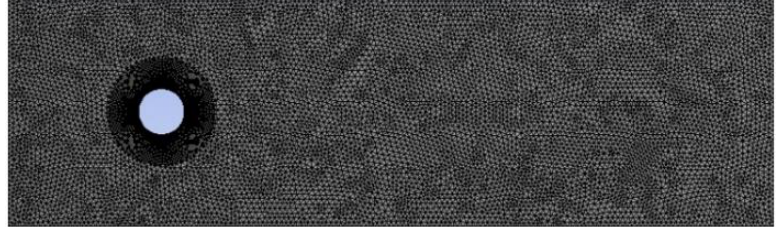
Figure 1. Example 1: Mesh of the flows past a circular cylinder in the channel.